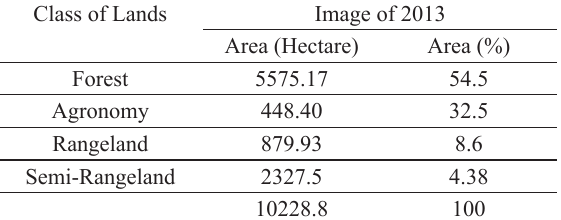
distribution of land use levels separately for year